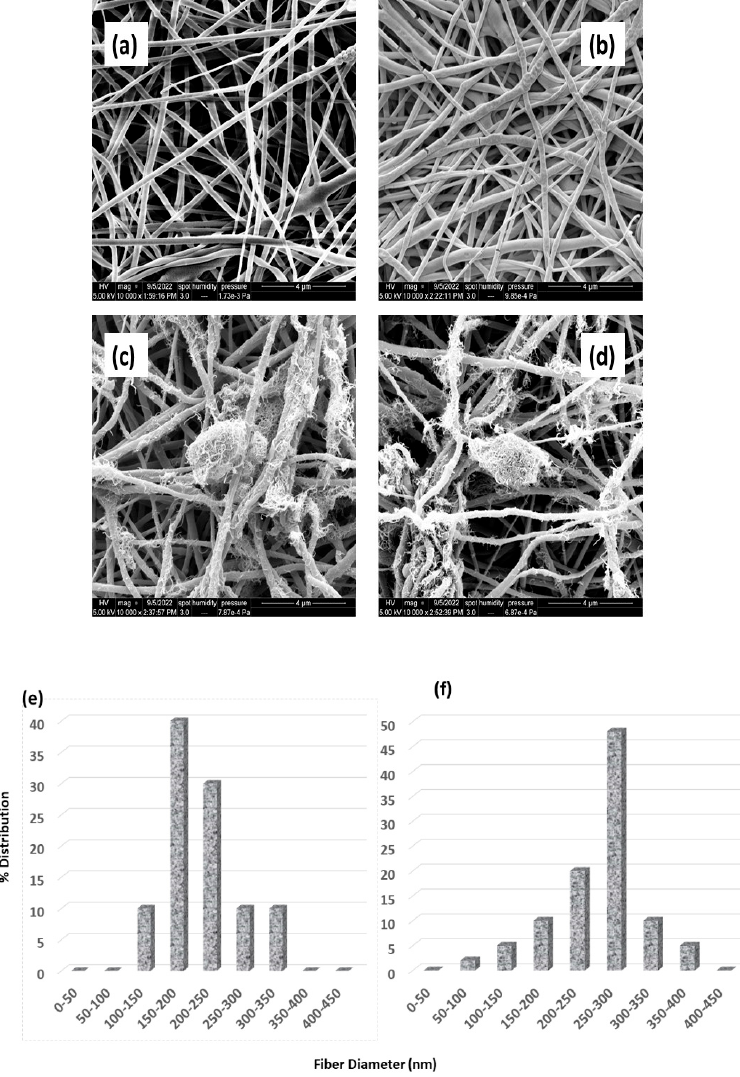
Figure 5. FESEM images of ( a ) PVDF-Co-HFP membrane before heat pressing, ( b ) PVDF-Co-HFP membrane after heat pressing, ( c ) PVDF-Co-HFP-CNT membrane before heat pressing, and ( d ) PVDF-Co-HFP-CNT membrane after heat pressing. ( e ) Nanofiber diameter distribution of PVDF-Co-HFP membrane before and ( f ) after heat pressing